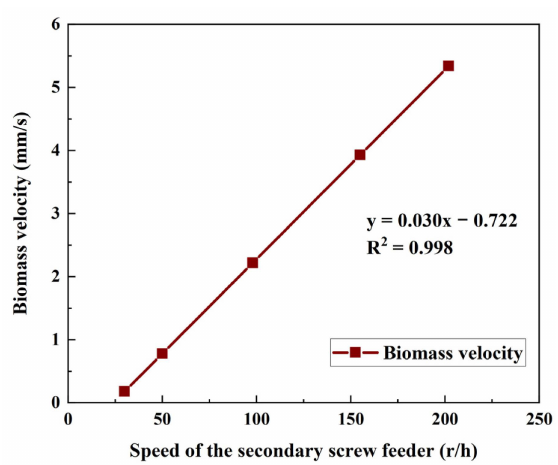
Figure 8. The relationship between biomass velocity and speed of the secondary screw feeder